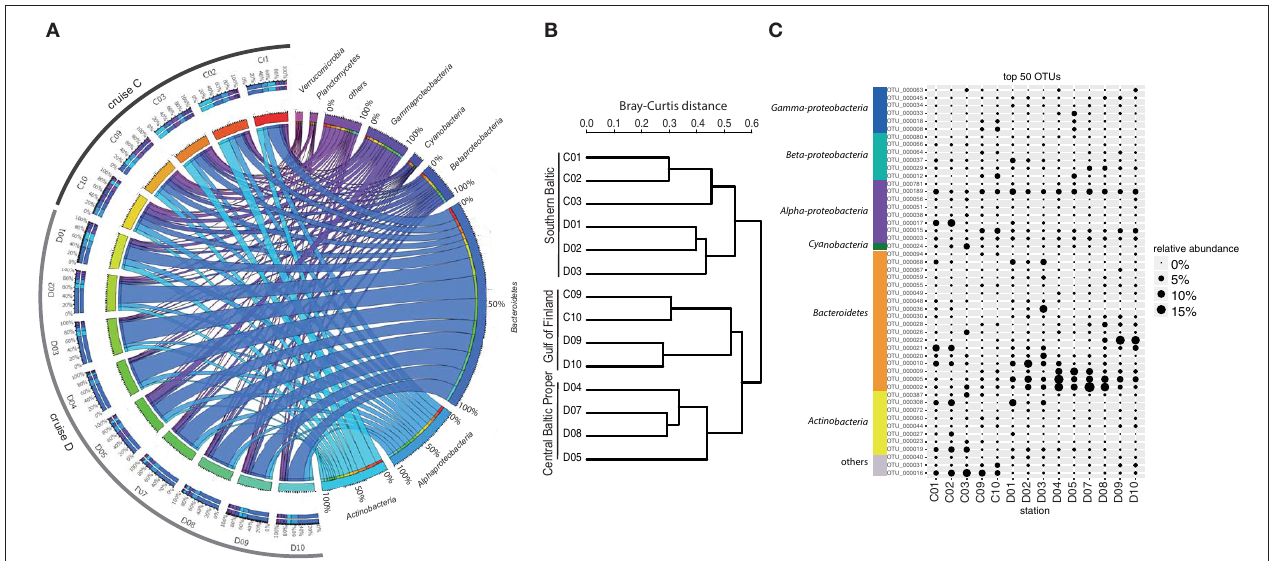
FIGURE 2 | Bacterial community composition and most abundant OTUs. (A) The figure displays relative OTU abundances grouped by bacteria phyla/classes in a circus graph. The right side of the graph visualizes relative OTU abundances of major bacteria phyla/classes summed over cruises C and D, as indicated by the size of the cells for each taxon (note color coding of ribbons connecting taxa with stations). Also shown are axes/cells for the taxon-normalized abundances at each station, as color-coded by station in the left side of the graph. Ribbons connect the relative abundances of the taxa with the color-coded stations on the left side of the graph, and width of ribbons is proportional to relative abundance. The left side of the graph indicates the relative abundances of the major taxa (color-coded according to taxa on right side of graph) at each sampled station during cruises C and D. Color-coding of stations (from red to blue-green) identifies proportions in inner circle/cells on right side of graph. (B) Beta-diversity analysis (beta-dendrogram, based on Bray–Curtis distance matrix), and (C) relative abundance patterns of the 50 most abundant OTUs across all stations. The group “others” in panel C comprises OTUs that have ≤ 92% sequence similarities to known sequences in NCBI ( NCBI Resource Coordinators, 2013). Relative abundance is calculated as % of total sequences obtained per sample (excluding sequences annotated as chloroplasts).